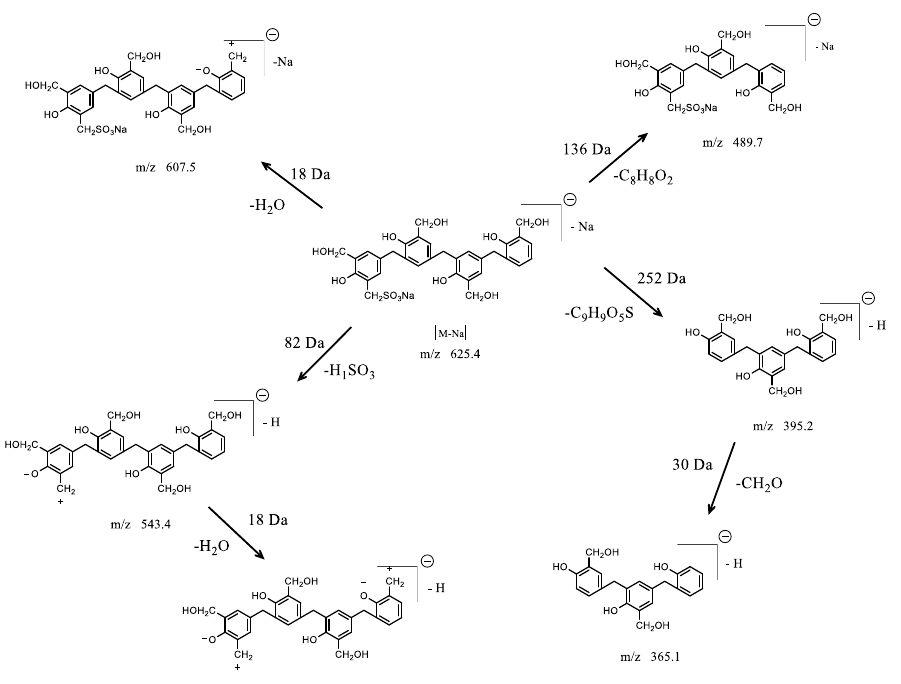
Figure 6. Proposed fragmentation pathway for the molecular ion with mass-to-charge ratio of m/z 625.4.